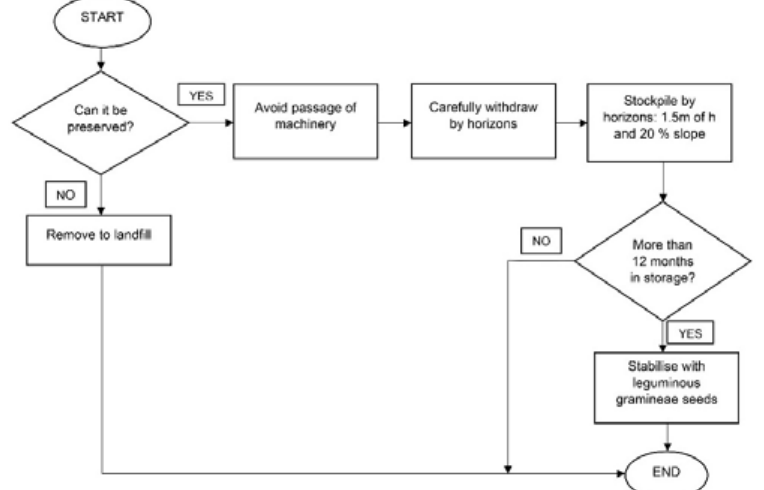
Fig. 5: Flow chart to control topsoil in mining